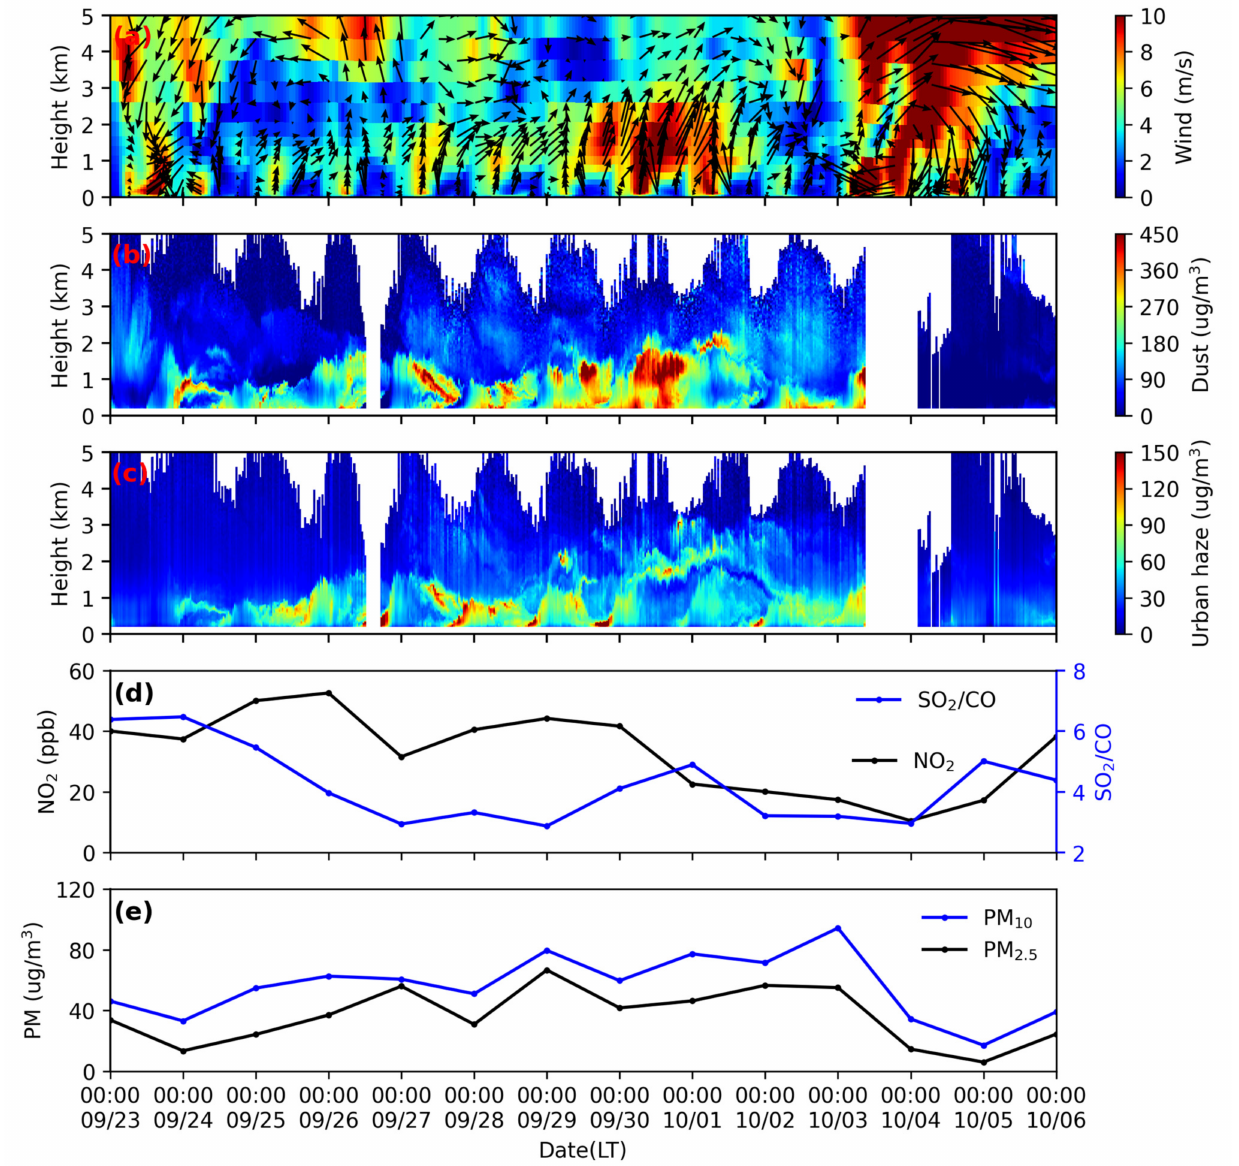
Figure 4. Air pollution in Beijing during the 2019 National Day military parade. The vertical structure of ( a ) horizontal winds simulated by WRF–Chem, ( b ) dust mass concentrations retrieved by PRL, and ( c ) urban haze mass concentrations retrieved by PRL. ( d ) Daily average NO 2 concentrations and SO 2 /CO ratios. ( e ) Daily average PM 2 . 5 and PM 10 mass concentrations. The black arrows in ( a ) represent the wind direction, and the downward arrow indicates the north